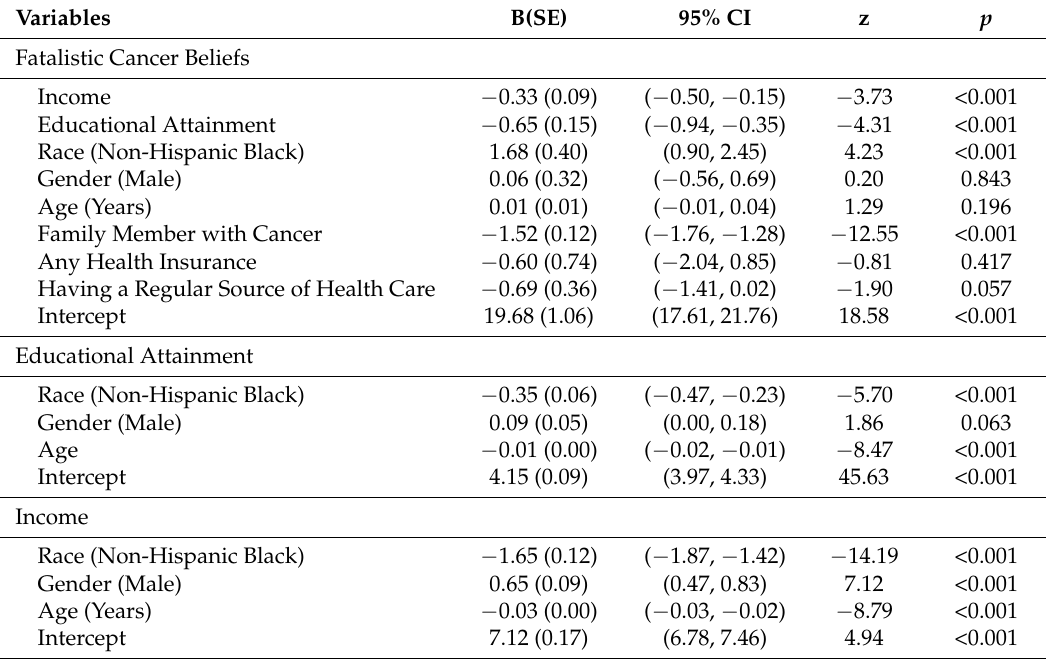
Table 3. Associations between race, socioeconomic status (SES; educational attainment and income), and fatalistic cancer beliefs in a nationally representative sample of American adults.